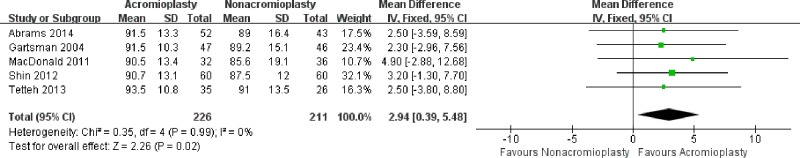
Forest plot of ASES score between the treatment of acromioplasty and nonacromioplasty.